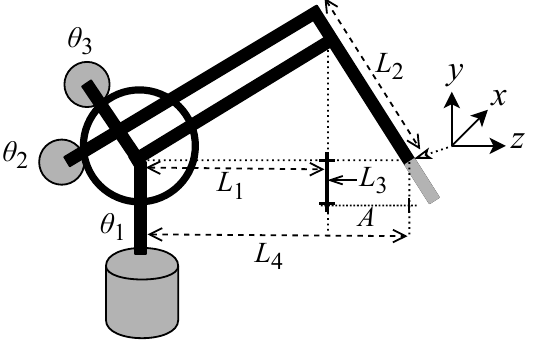
Figure 20. Structure of 3DOF Phantom Omni robotic